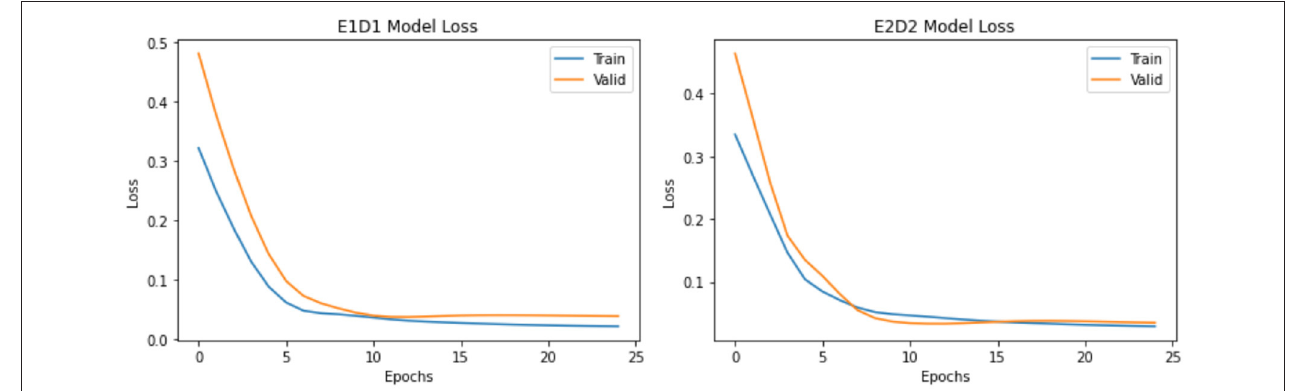
FIGURE 2 | Comparison of model loss (multivariate E1D1 vs. E2D2).